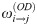
Probabilities of transition between stations.We explore the relation of the probability of transition ωi→j(OD) and the respective geographical distance dij between stations i and j for the activity of BSS users in (a) Chicago and (b) New York. We present hexagonally binned two-dimensional histograms for the logarithm of ωi→j(OD) and the logarithm of dij/d0 where d0 = 1 Km is a reference distance. Dashed lines depict the best fit described by Eq (4) for the pairs (log10(dijd0),log10wi→j(OD)) with i, j = 1, 2, …, N. The values codified in the colorbar represent the frequencies f(dij,ωi→j(OD)) found in each hexagonal bin and presented as a logarithm.